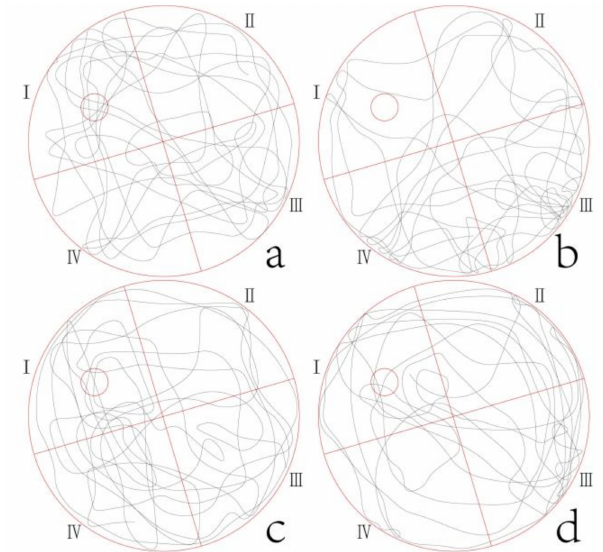
Figure 1. Swimming trajectories of space exploration in normal group ( a ), model group ( b ), positive group ( c ), and peppermint essential oil group ( d ). The quadrant where the original platform was located was set as I, and defined quadrants as II, III and IV clockwise in turn, with equal area of each quadrant.